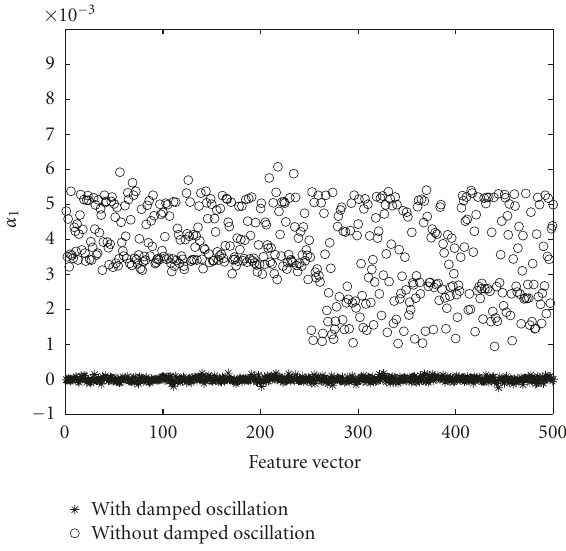
Figure 22: HOS-based features extracted from u to classify the os- cillatory transient named damped oscillation, α 1 = (cid:21) c 2, u (257).